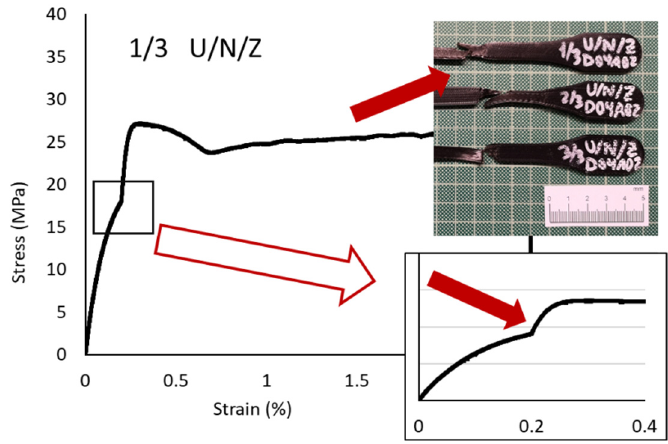
Figure 13. Initial tear on U/N/Z sample and its representation on stress-strain graph.